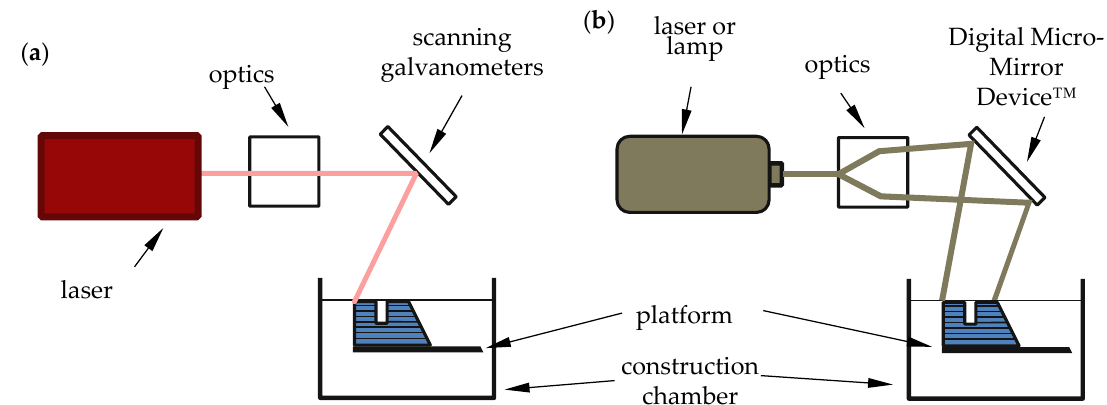
Figure 12. Schematic representation of stereolithographic processes: ( a ) vector scan SLA, ( b ) mask projection SLA (based on [30]).